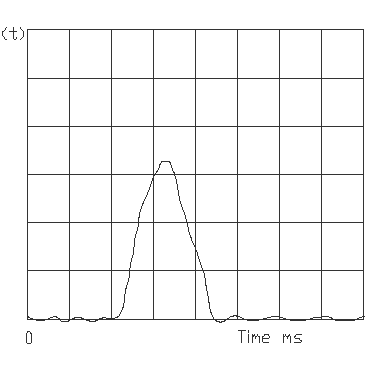
Figure 5. Injection rates at individual nozzle holes n=700 rpm, Q